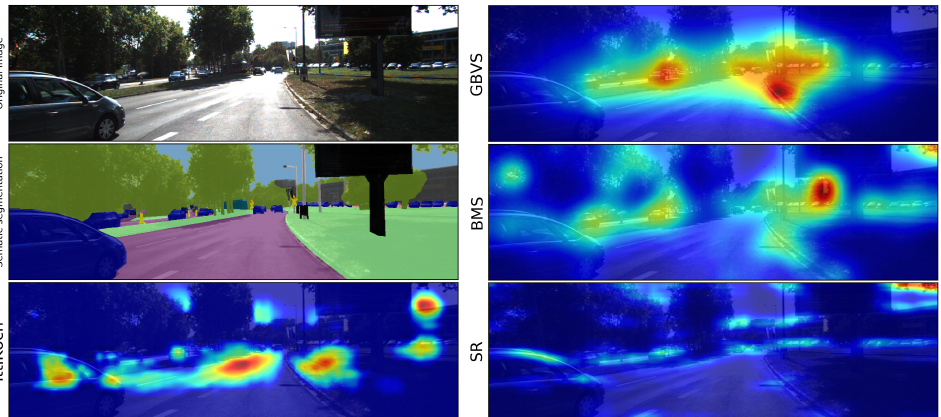
Figure 1. Example of an image, its semantic segmentation and the corresponding saliency maps obtained with different bottom-up models. The example illustrates how salient areas identified with different models differ on their shape, size, location and saliency level. The models are described in Section